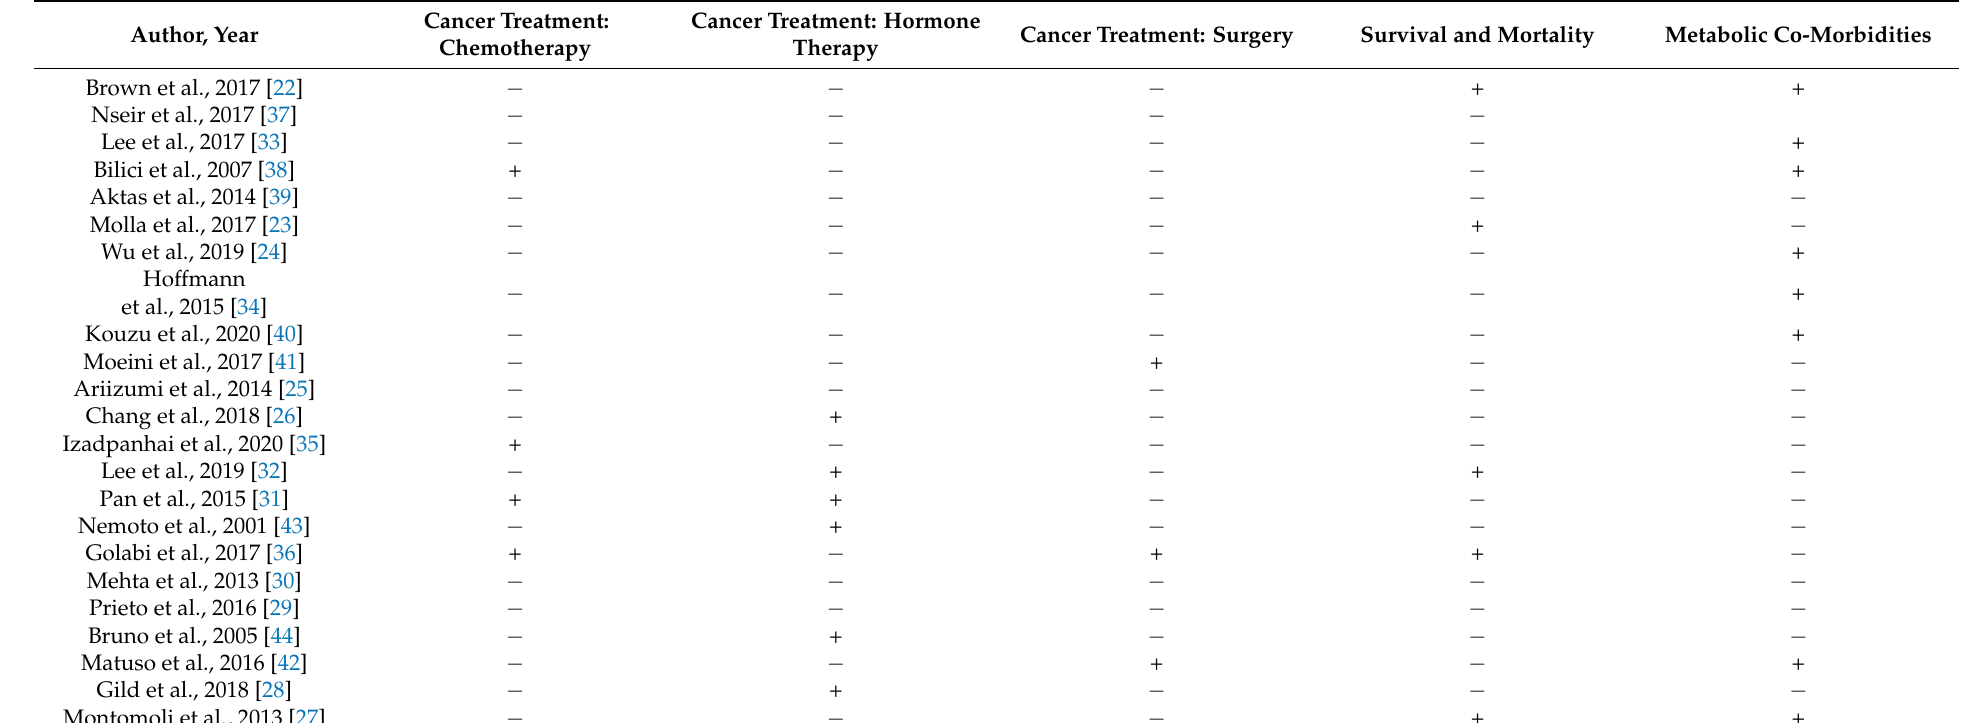
Table 3. Study outcomes related to treatment modalities, survival and mortality and co-morbidities and risk of NAFLD 1